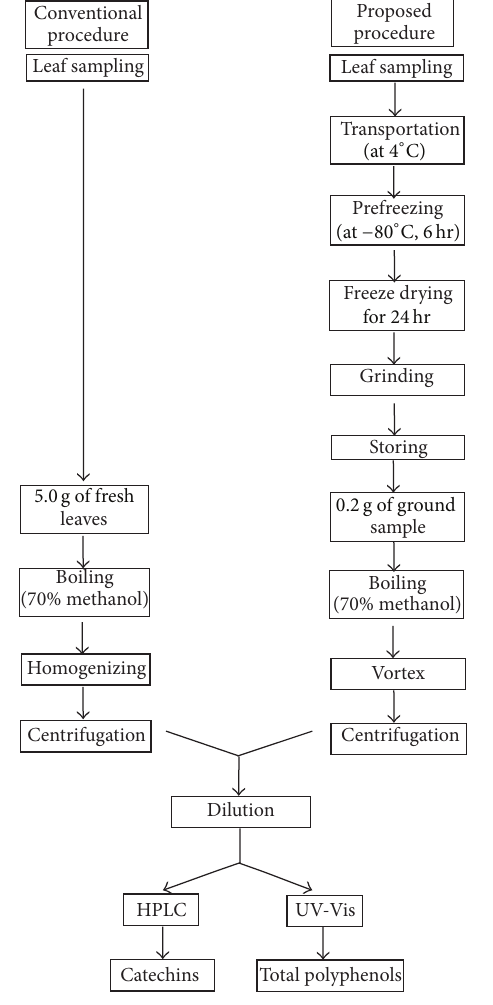
Figure 1: Steps of conventional and new sample preparation pro- cedure for metabolite analysis of tea.